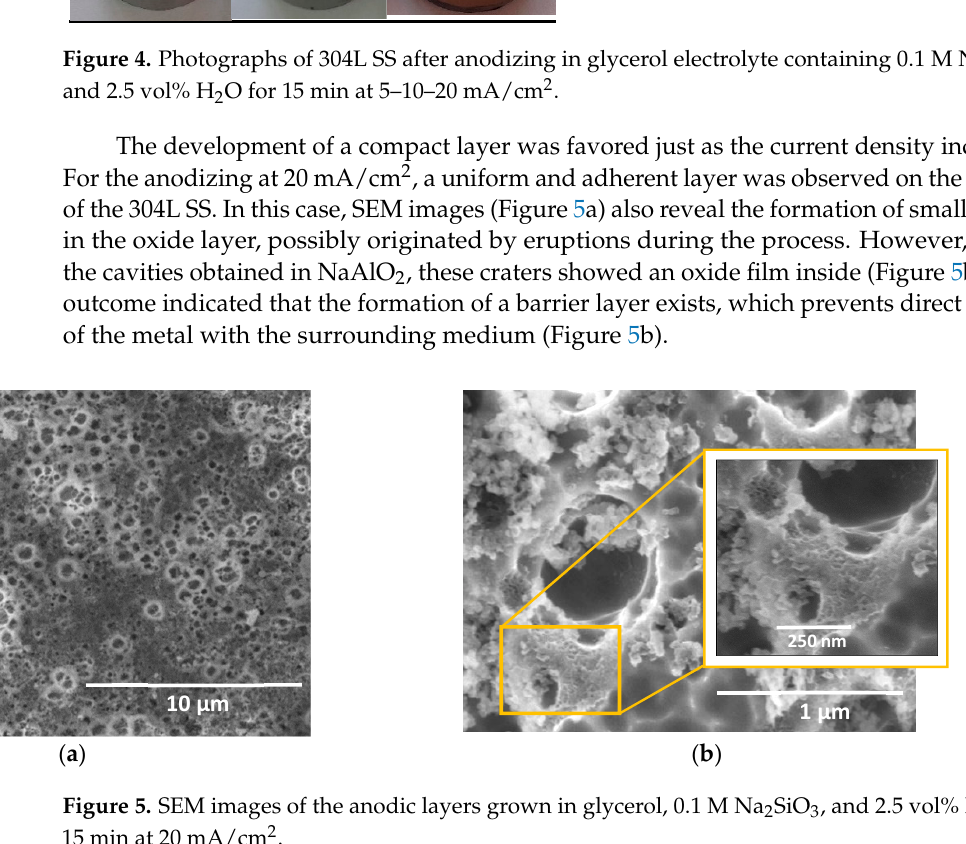
Figure 4. Photographs of 304L SS after anodizing in glycerol electrolyte containing 0.1 M Na 2 SiO 3 and 2.5 vol% H 2 O for 15 min at 5–10–20 mA/cm 2 .